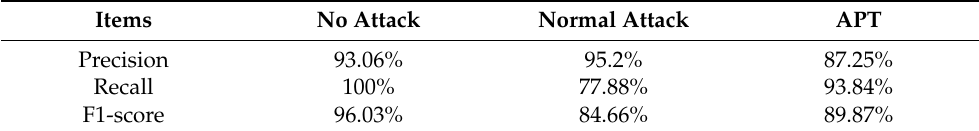
Table 9. The evaluation of the results.